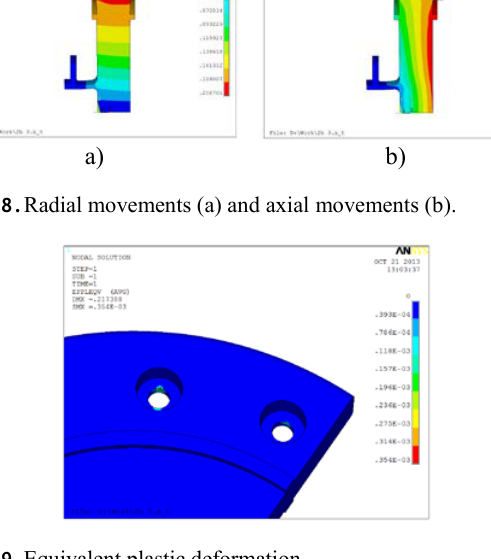
Fig. 9. Equivalent plastic